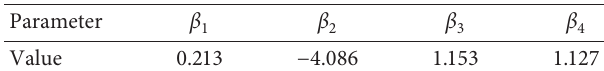
Table 2: The values of parameters of critical moment with no torsional bracing 􏽥 M (equation (16)). cr0